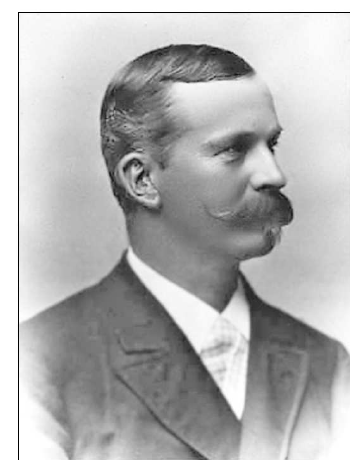
Fig. 4. J(cid:127)ons Svanberg 1771{1851. Image: Centre for History of Science { The Royal Swedish Academy of Sciences.